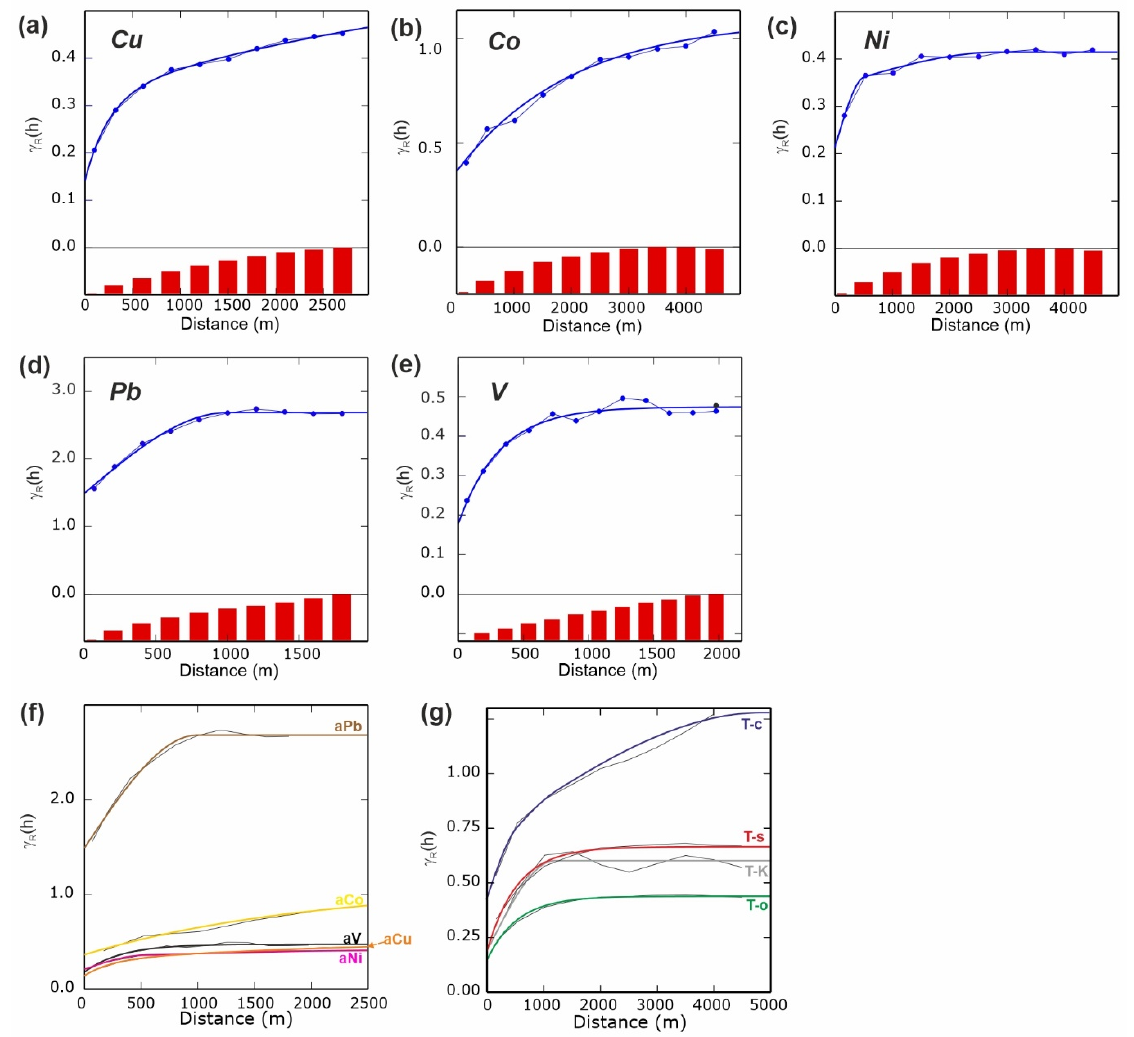
Figure 8. ( a – e ) Relative variograms (points) and their theoretical models (solid lines) of the Cu abundance and the abundance of accompanying elements in the Cu-Ag deposit; ( f ) Comparison of relative variograms and their theoretical models in one scale; ( g ) Comparison of relative variograms and their theoretical models of the thickness of ore deposit (T-o) and three basic lithological series (T-c—the carbonate ore, T-K—the Kupferschiefer ore, T-s—sandstone ore).